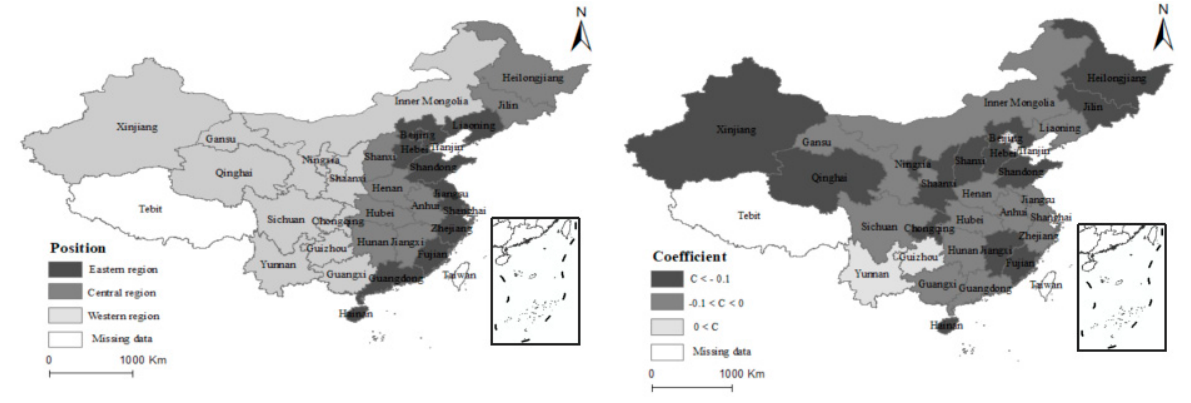
Figure 4. Classification of the regression coefficient.